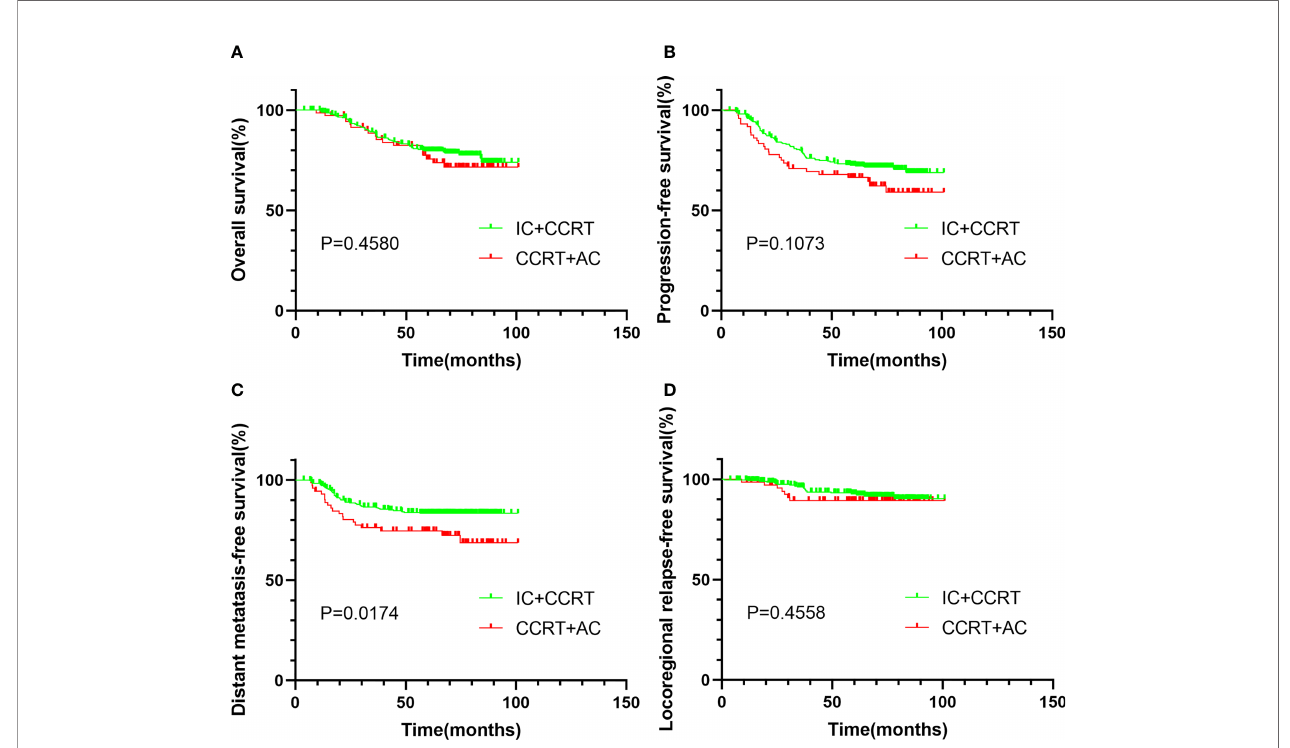
FIGURE 1 | Kaplan – Meier survival curves of OS (A) , PFS (B) , DMFS (C) , and LRRFS (D) for patients strati fi ed as IC + CCRT and CCRT + AC before PSM. OS, overall survival; PFS, progression-free survival; DMFS, distant metastasis-free survival; LRRFS, locoregional relapse-free survival; IC, induction chemotherapy;